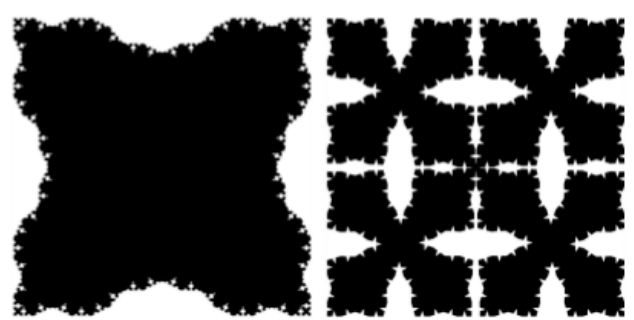
Figure 4. Inward curves.